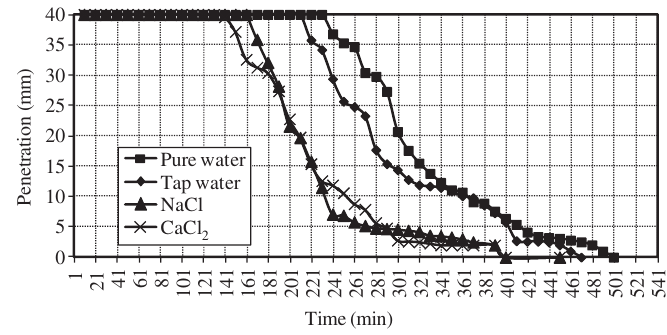
Figure 3 Needle penetration on the vicat apparatus for cement